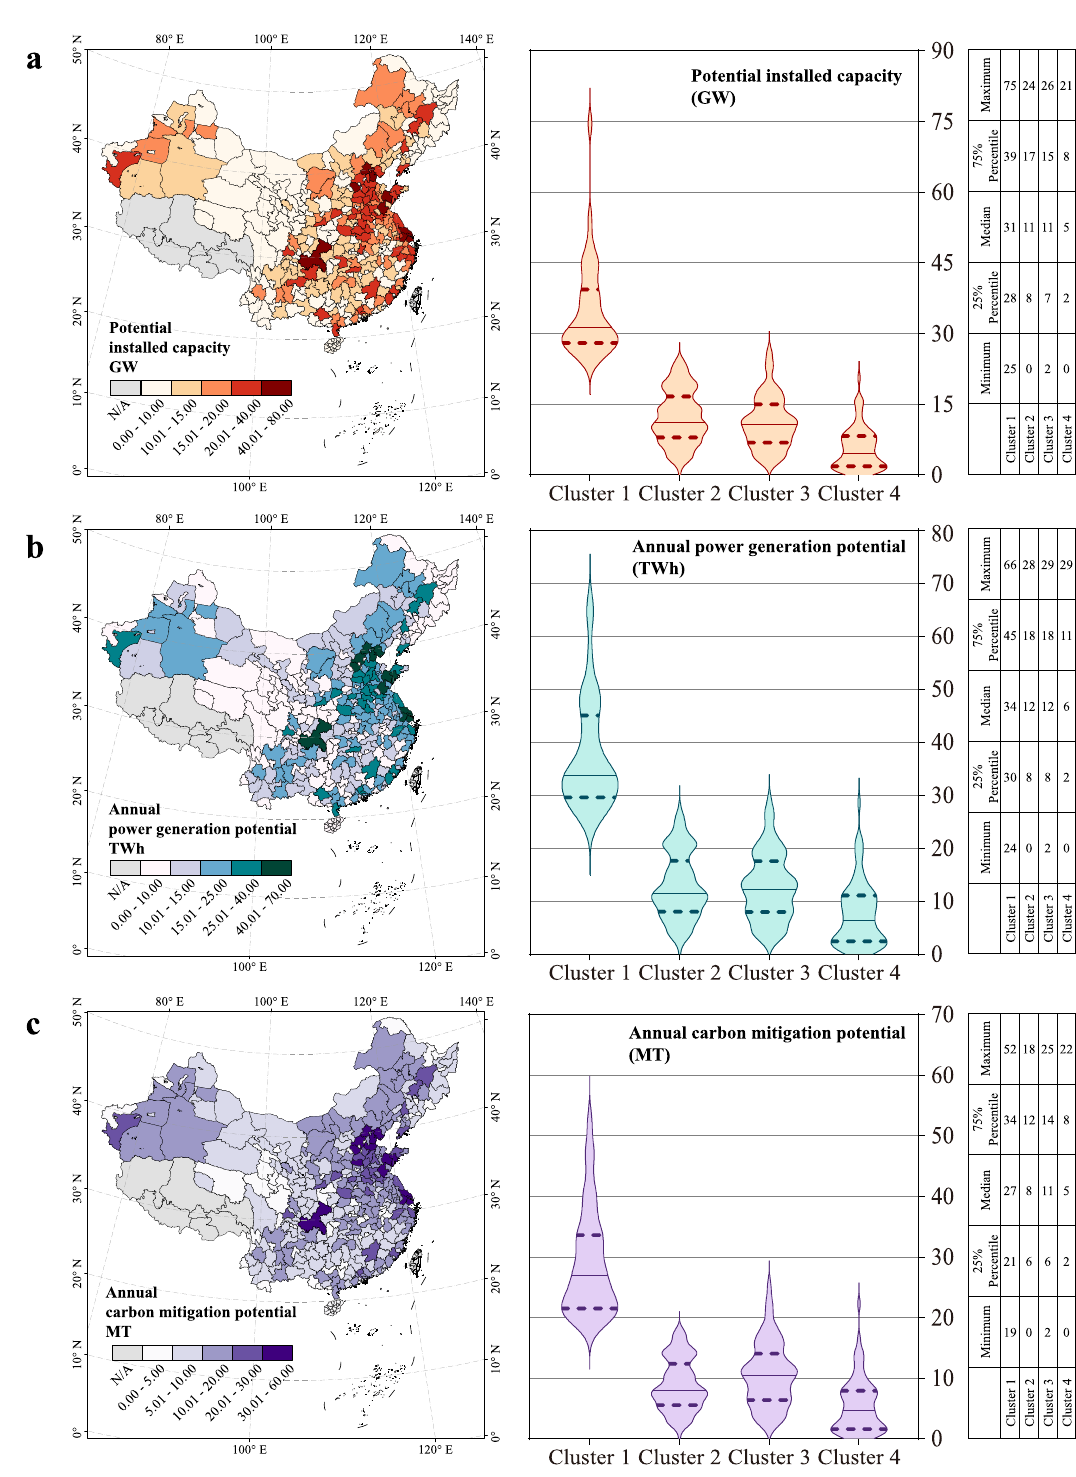
Fig. 5 | Key indexes ofthe RPV carbon mitigationpotential assessmentfor 354 Chinese cities in 2020. a Geographical distribution of the RPV installed potential, b power generation potential, and c carbon mitigation potential for the 354 cities. Theleftandrightsidesofthe fi gurerepresenttheresultsaggregatedatthecityand cluster levels, respectively. The cities in Cluster 1 generally have the largest